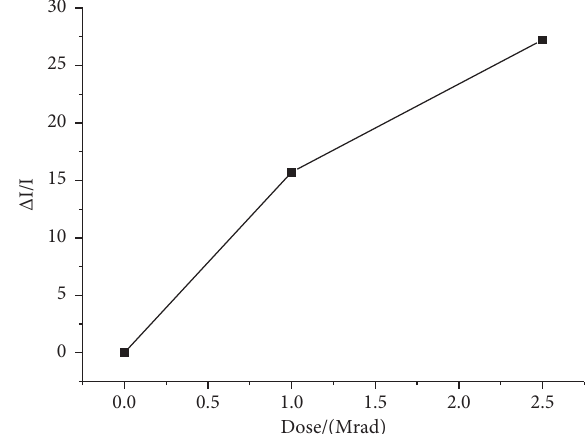
Figure 2: Variation of current with total dose ( U �